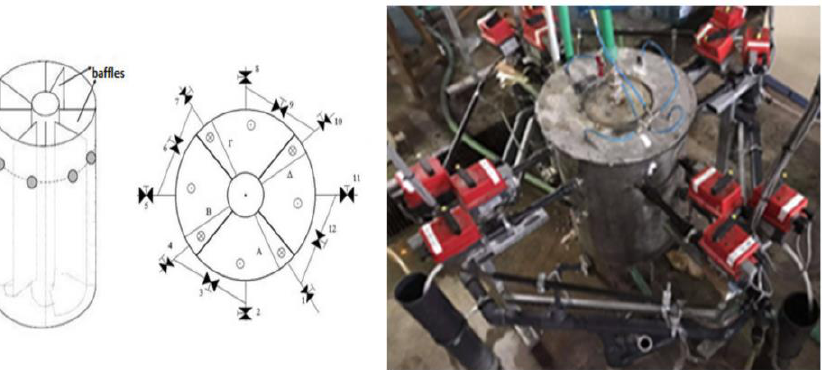
Figure 1. Experimental setup of the PABR used in the experiments. A,B, Γ , Δ indicate the compartments of the reactor. Valves 1,4,7,10 are the inlet valves of compartments A,B, Γ , Δ while valves 2,5,8,11, are their effluent valves. Valves 3,6,9,12 control the communication between the compartments.